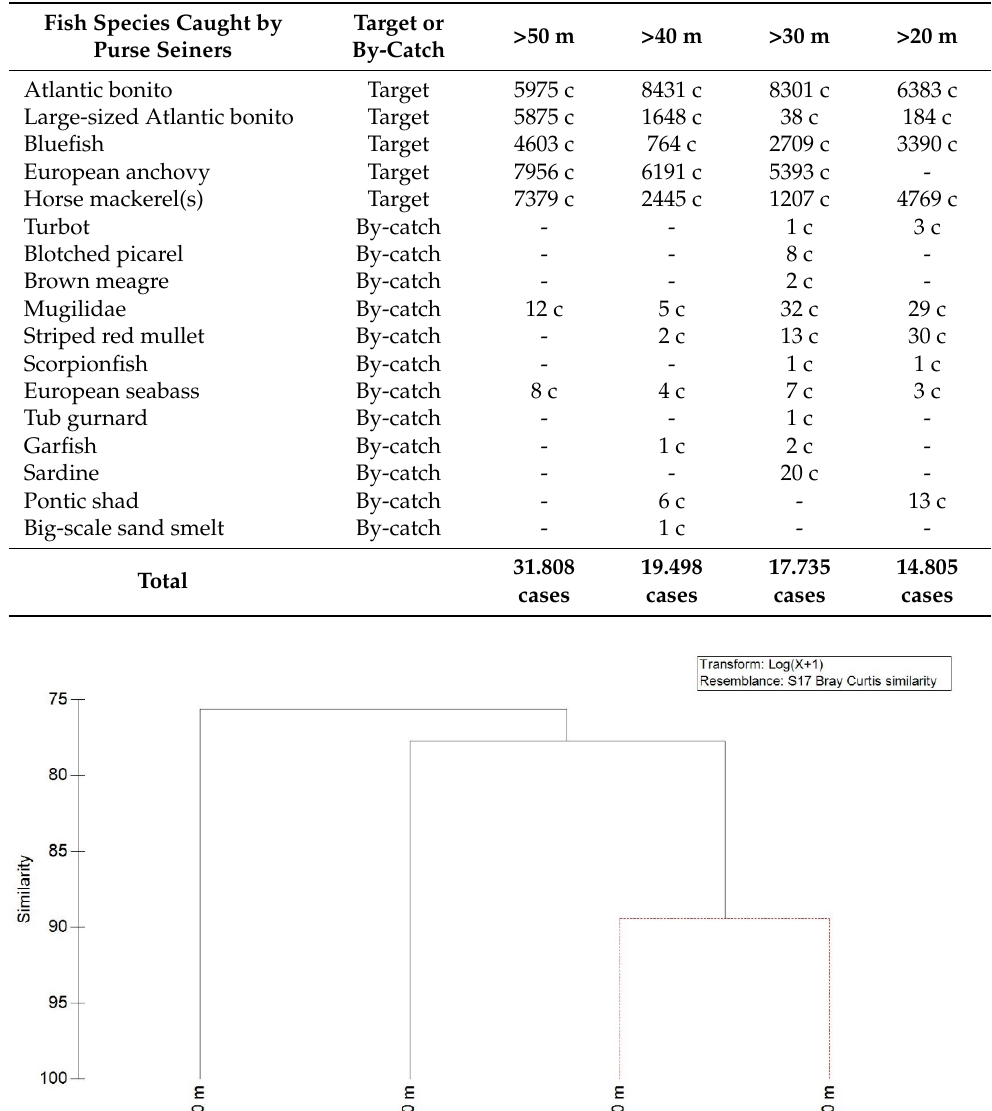
Table 3. Average annual catch totals by species per vessel length category for 2020 (in cases-c).